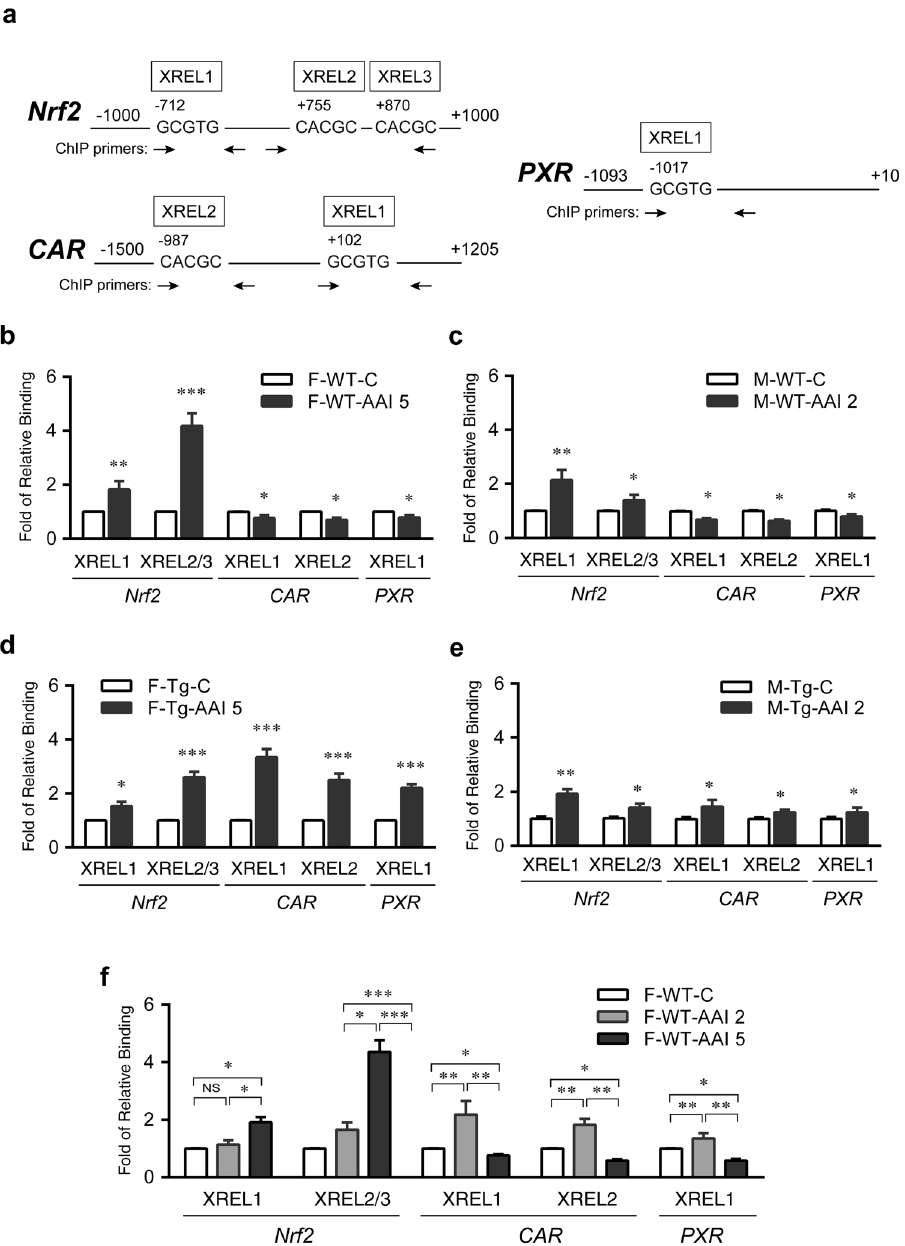
Figure 7. GNMT interacts with the promoters of the genes encoding Nrf2, CAR and PXR, nuclear transcription factors. (a) The chromatin was immunoprecipitated with mouse anti-GNMT antibody (14-1) or mouse IgG (negative control). ChIP-enriched DNA was amplified with the primers for XREL1, XREL2 and XREL3 regions on the promoter of Nrf2 , PXR , and CAR genes. Schematic represents the upstream promoter binding regions of XREL1, XREL2 and XREL3 in the Nrf2 (XREL1: − 712 to − 708; XREL2: + 755 to + 759; XREL3: + 870 to + 874) , CAR (XREL1: + 102 to + 106; XREL2: − 987 to − 983) and PXR (XREL1: − 1017 to − 1013) genes. Horizontal arrows indicate the location of primers used for qPCR in site-specific ChIP assays. Note that the figure is not drawn to scale. (b–e ) ChIP-qPCR analyses were performed with the liver lysates from AAI- or corn oil (C)-treated WT ( b , female, F; c , male, M) and hGNMT Tg mice ( d , female, F; e , male, M), as described in Figs 1 and 2. ( f ) ChIP-qPCR analyses were performed with the liver lysates from 3-week AAI- and corn oil (C)-treated WT female mice, as described in Fig. 4a (AAI 2 or AAI 5: 2 or 5 mg/kg BW/day AAI administration). The quantity of DNA in the precipitation with GNMT antibody was normalized to the IgG control. Values are presented as the mean ± SEM, n = 4. p -values were analyzed using the one-way ANOVA or Student’s t -test. * p < 0.05, ** p < 0.001, *** p ≤